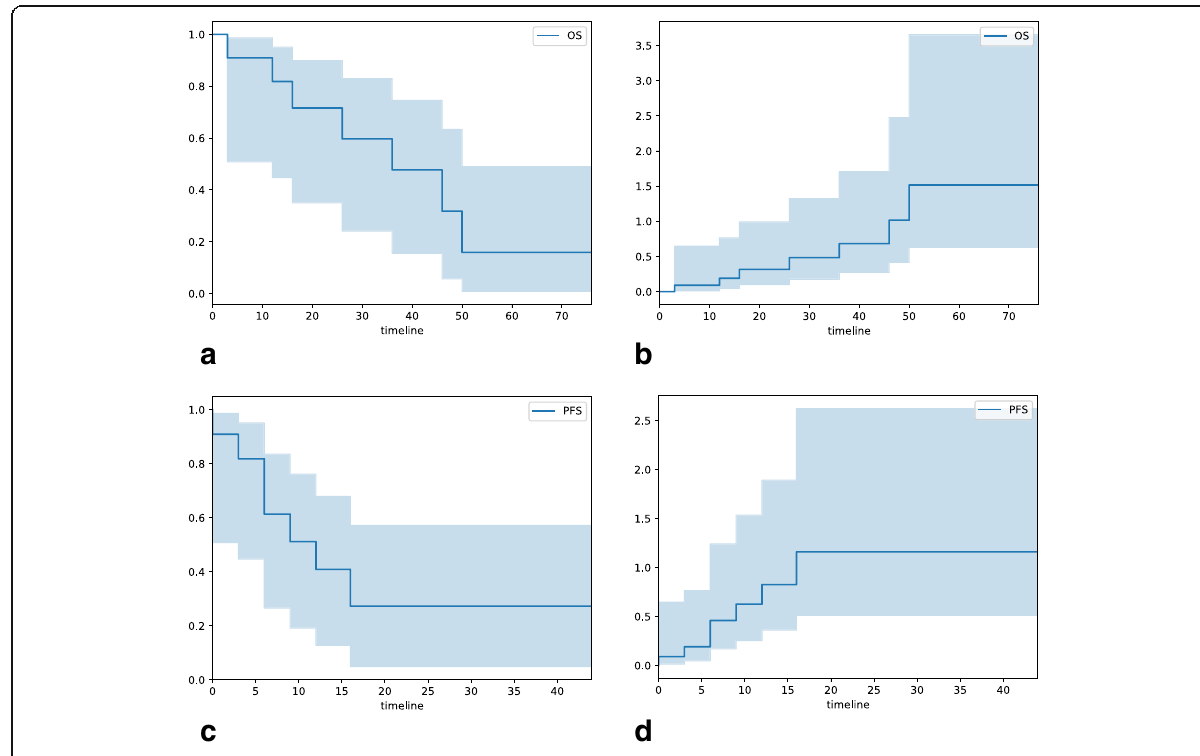
Fig. 3 Life table analysis determined OS and PFS using the Kaplan – Meier ( a , c ) and Nelson – Aalen estimators ( b , d